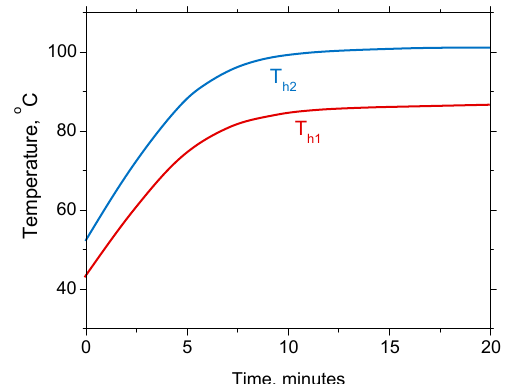
Figure 5. Temperature of both heaters versus the current through the larger heater I h1 when the current of the smaller heater I h2 is kept constant (80 mA).